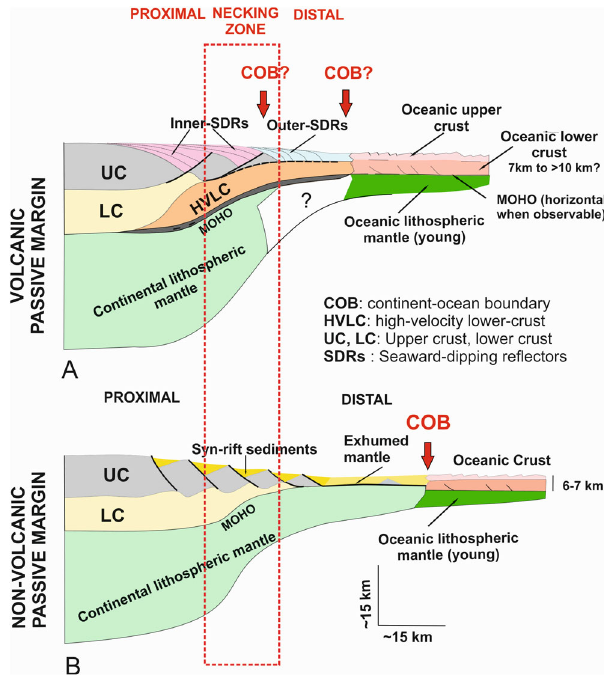
Fig. 1 Simpli fi ed sketches of crustal domains at passive margins. A Volcanic passive margins. Based from the present study and from a synthesis of crustal-scale observations at VPMs 1 – 3,8,12,13,18,21,22,41,43,45,48 – 50 ; B nonvolcanic passive margins simpli fi ed from 51,52